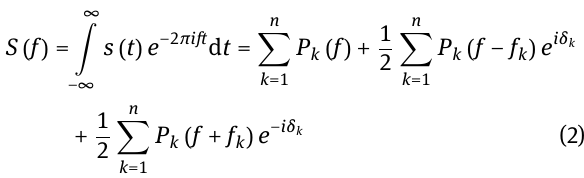
flow cytometry to image every single cell flowing at a speed of 1 m/s, corresponding to a high throughput of 25,000